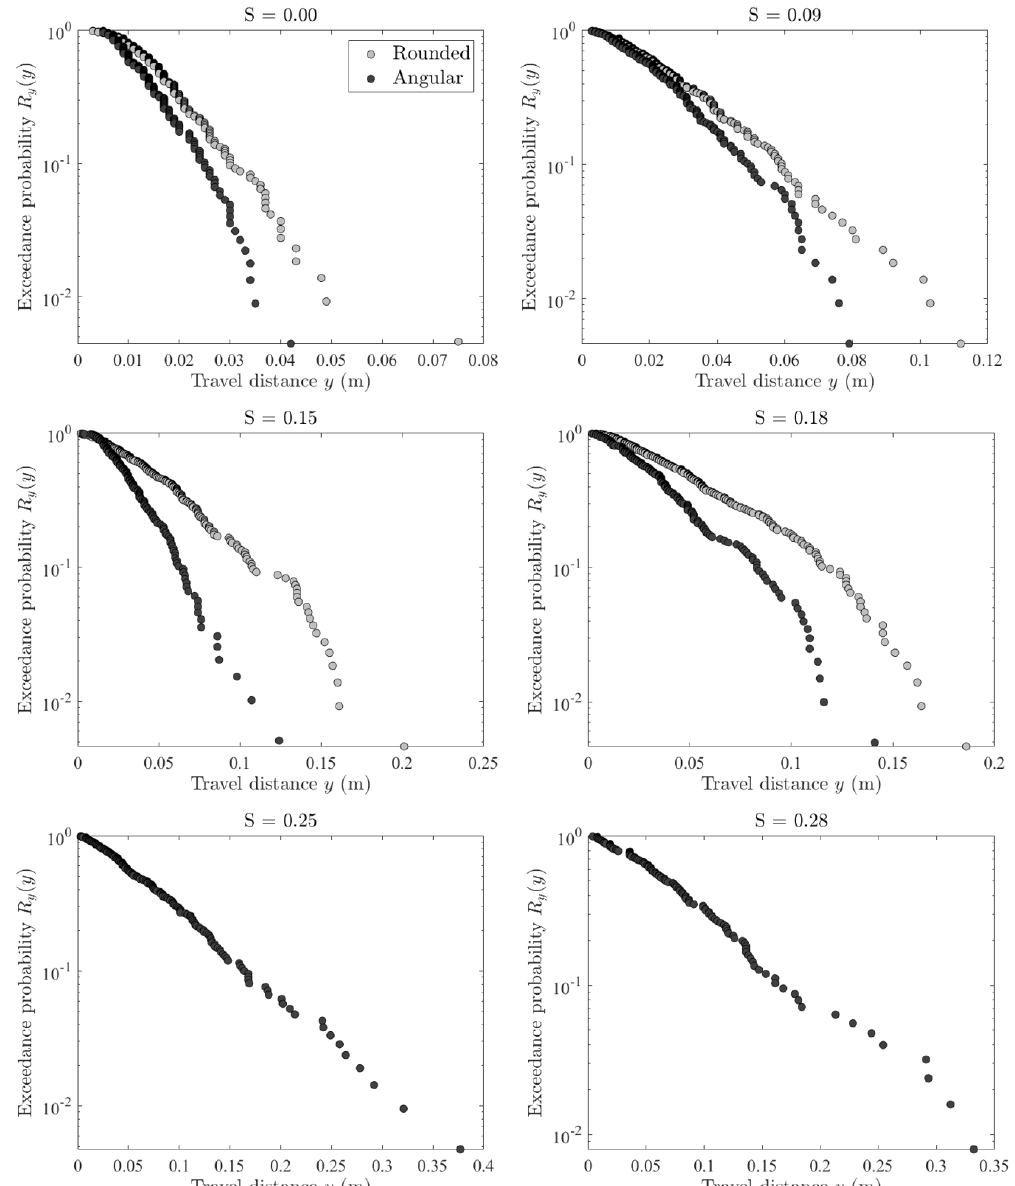
Figure 12. Plots of exceedance probabilities versus the absolute value of transverse slope travel distance for experiments over six values of slope S . The transverse mean position remains close to zero, demonstrating that there is no preferential drift to − y or + y as illustrated in Fig. 11. The concavity of the plots suggests that transverse diffusion is dominated by cooling. No energy in addition to that partitioned from downslope motion is put into lateral